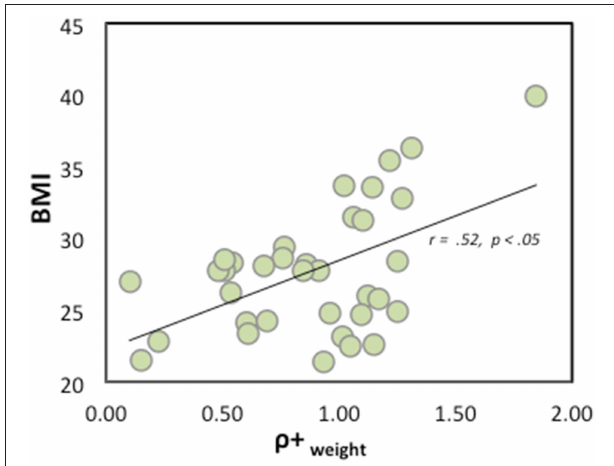
FIGURE 3 | Scatter plot between weight-loss risk preference parameters and BMI scores in satisfactory group. ρ + weight = 1 represents risk neutrality. ρ + weight > 1 represents risk-seeking, whereas ρ + weight < 1 represents risk-aversion. Note significant correlation even after removing an individual with BMI of 40.